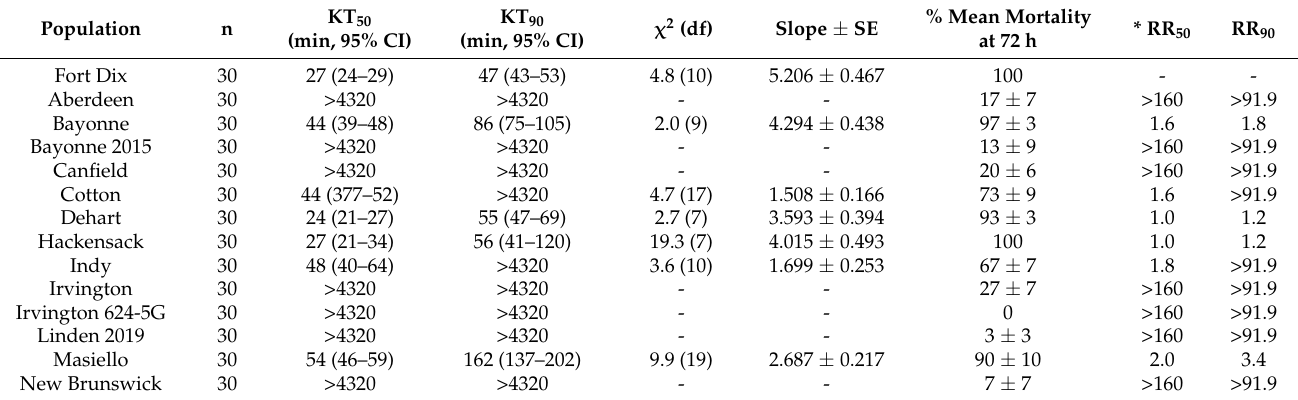
Table 4. Susceptibility (based on knockdown time, KT 50 KT 90 ) of 13 field-collected C. lectularius populations to topically applied deltamethrin at a discriminating dose of 115 ng per adult.